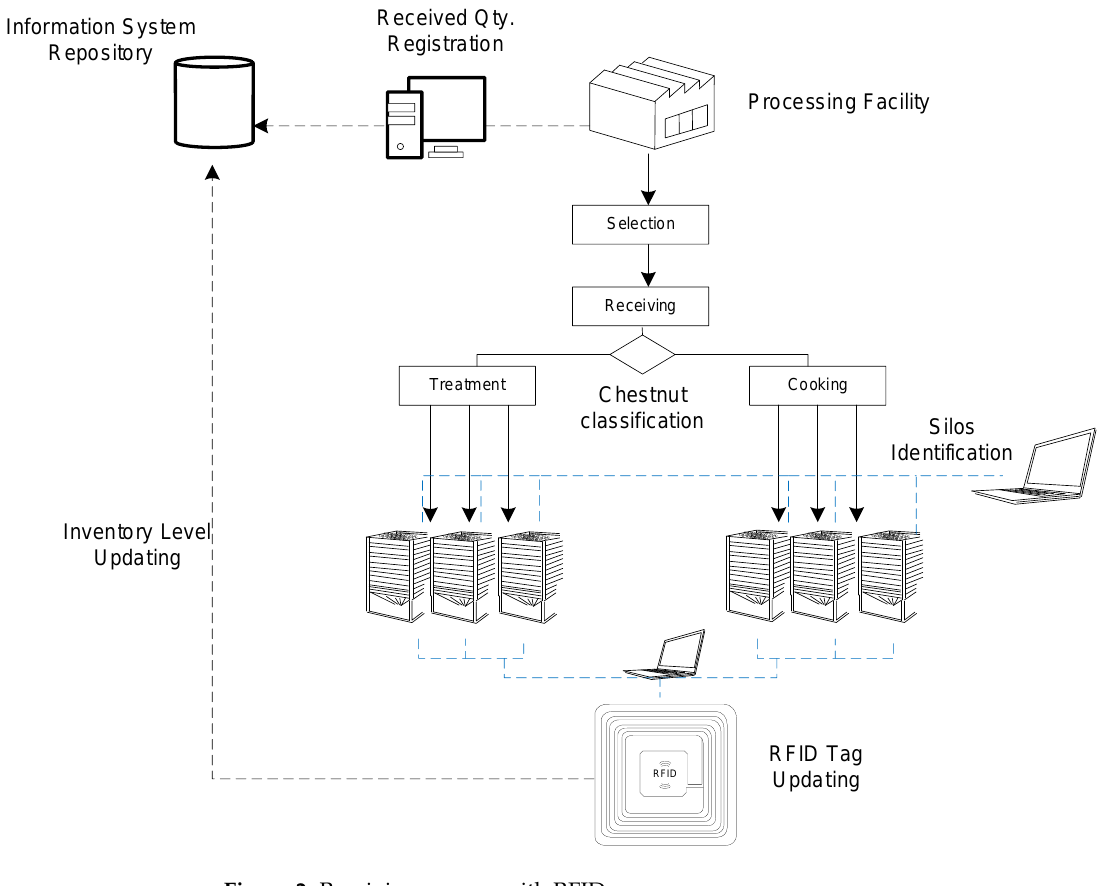
Figure 2. Receiving process with RFID.